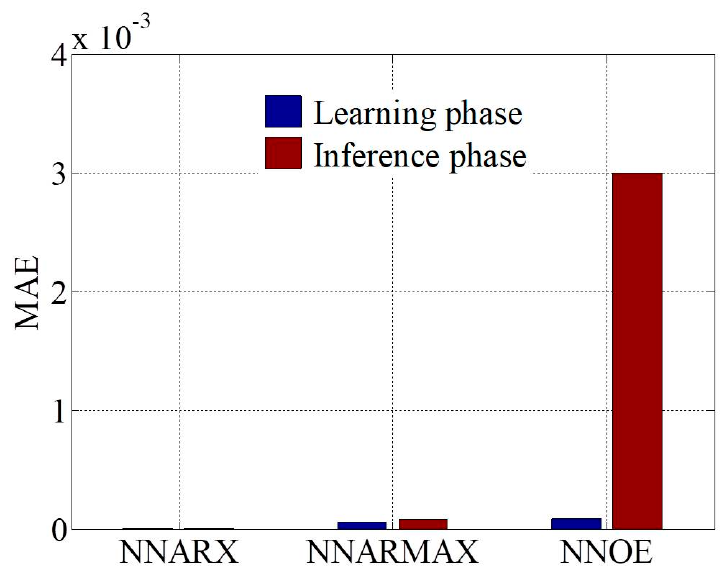
Figure 8. MAE of the degradation prediction in the learning phase and inference phase.